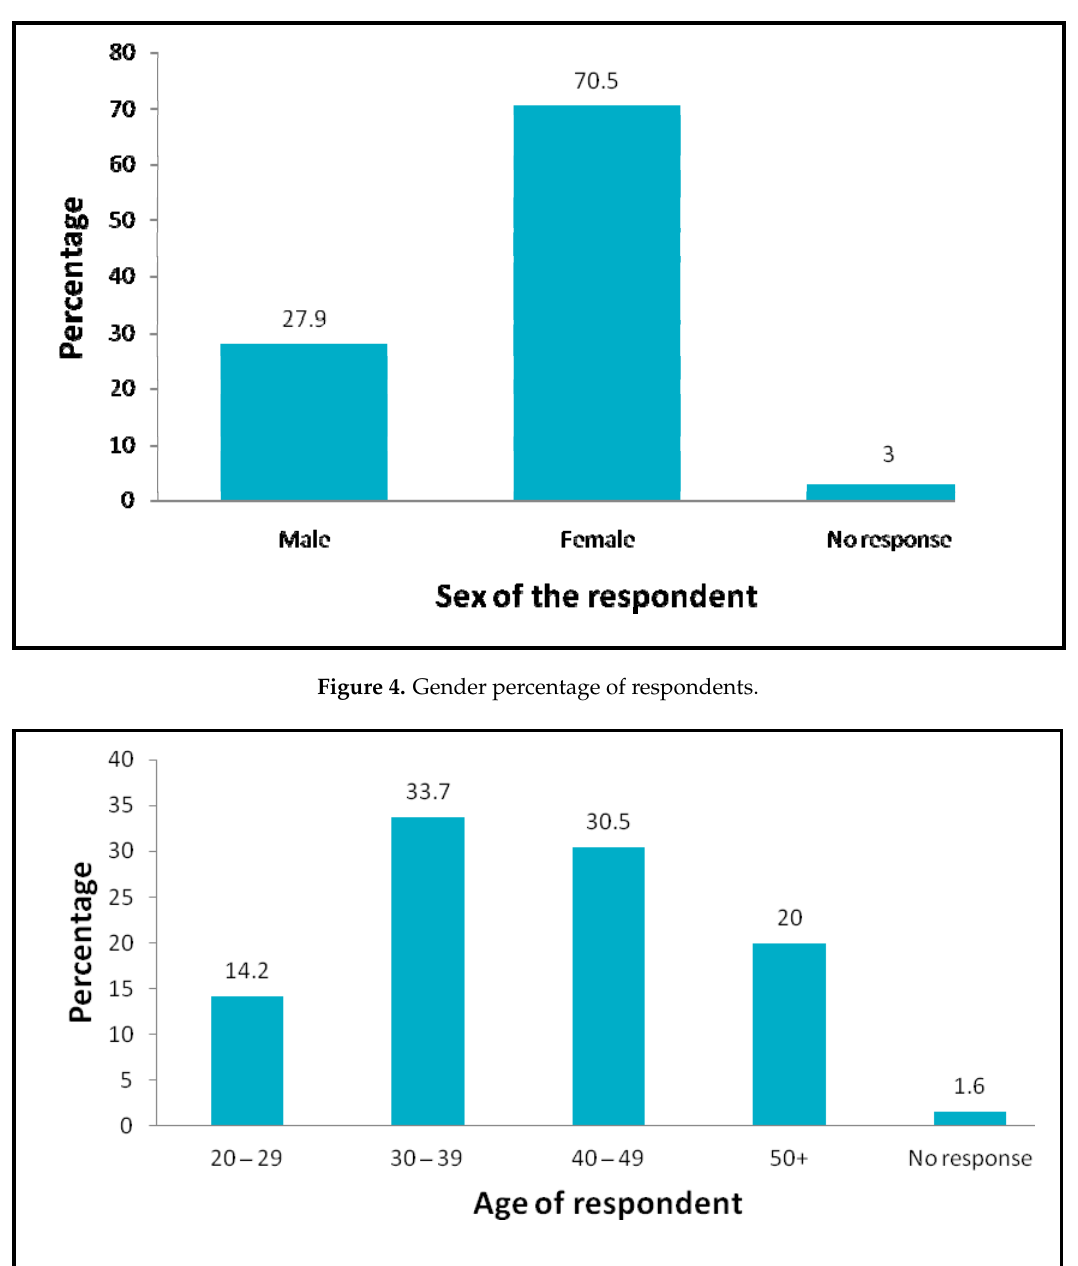
Figure 5. Age variation of respondents.